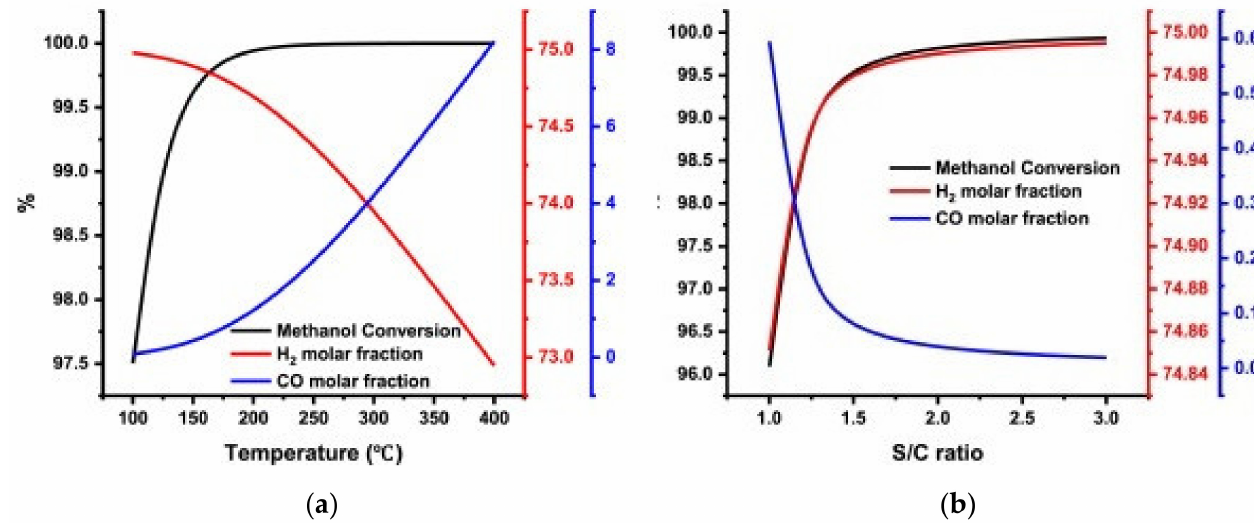
Figure 4. ( a ) Effect of temperature (100–400 ◦ C) on SRM reaction system; pressure: 1.0 atm, S/C ratio:1.2. ( b ) Effect of S/C ratio (1.0–3.0) on MSR reaction system; temperature: 120 ◦ C, pressure:1.0 atm. (Adapted from [64], copyright 2020, Elsevier.)